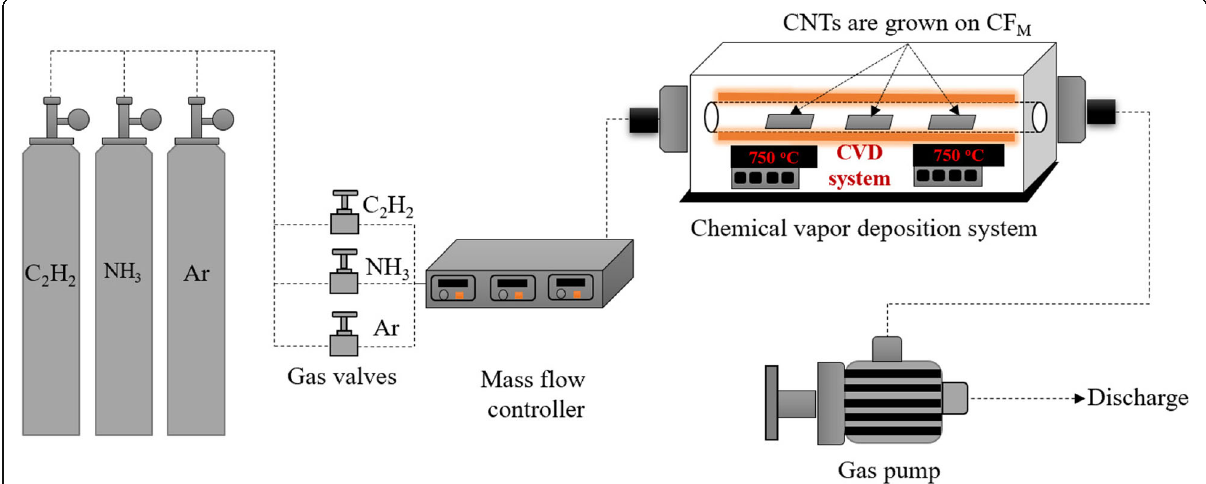
Fig. 1 Schematic diagram of the chemical vapor deposition apparatus employed in this